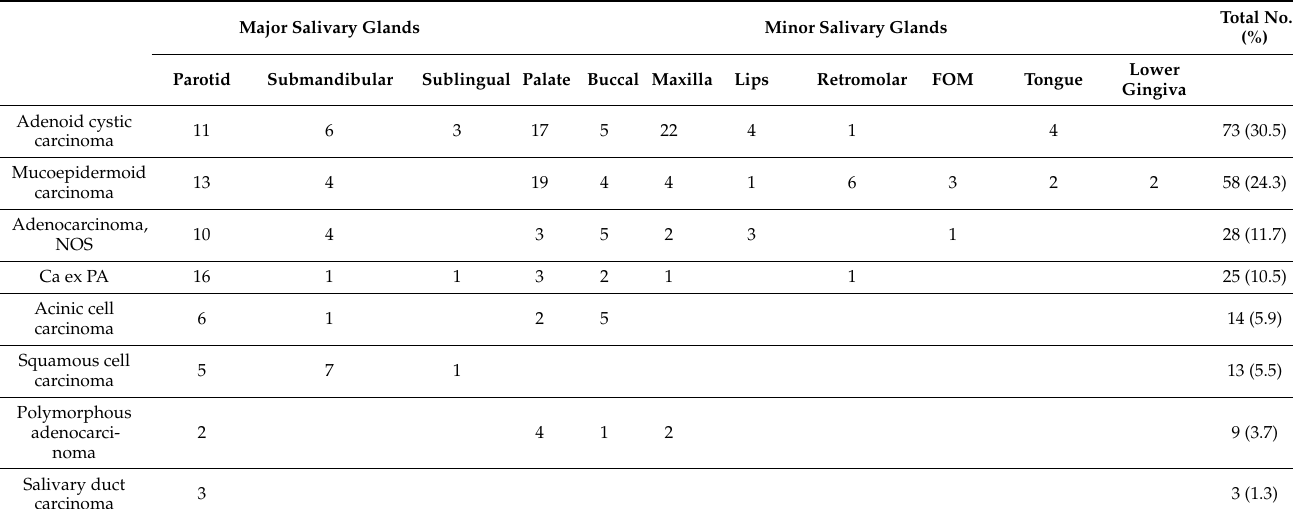
Table 2. Location and histological type of malignant salivary gland